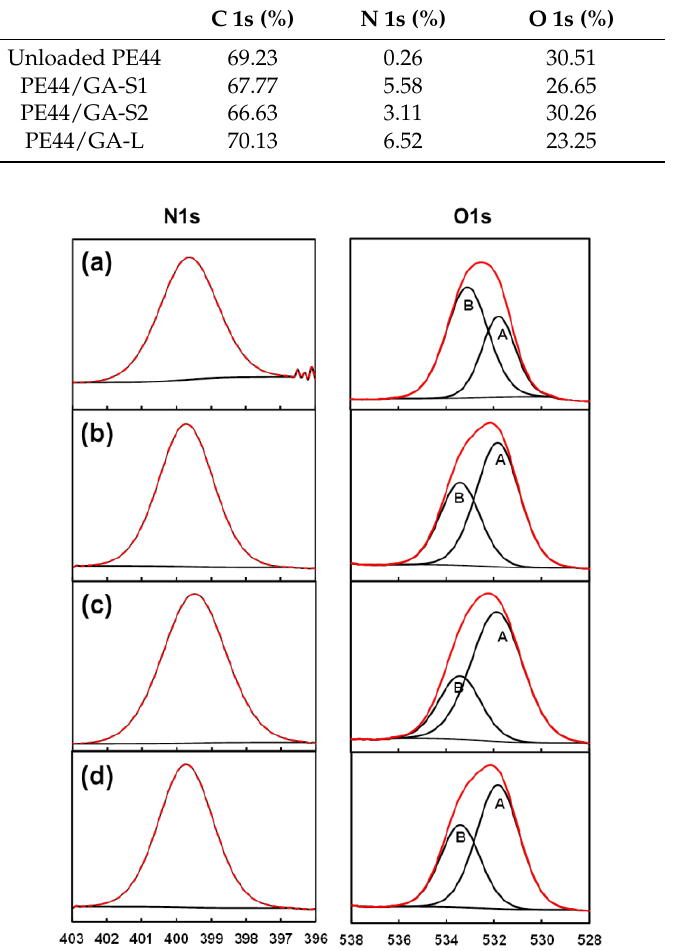
Table 2. Atomic percent composition (C 1s, N 1s and O 1s) obtained by XPS for unloaded PE44,